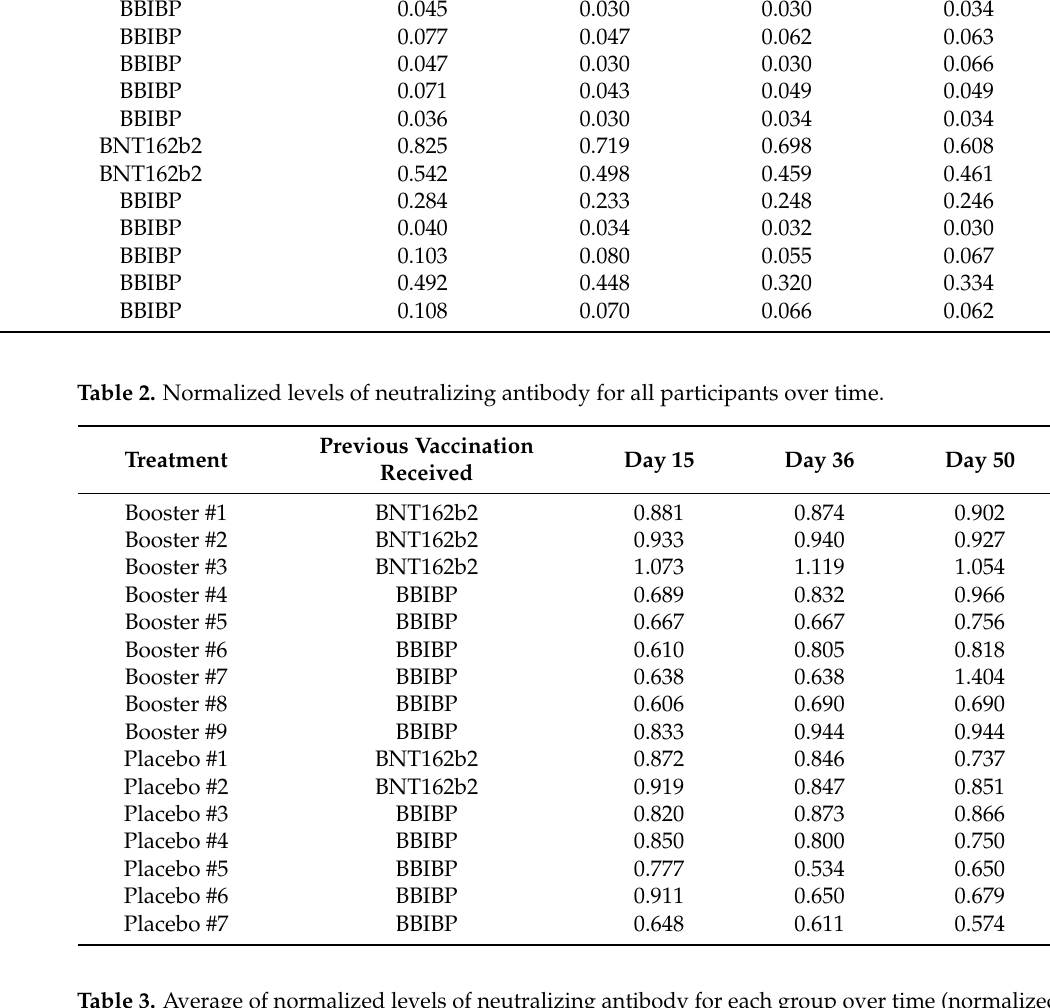
Table 3. Average of normalized levels of neutralizing antibody for each group over time (normalized by assuming the level of neutralizing antibody level on day 1 as